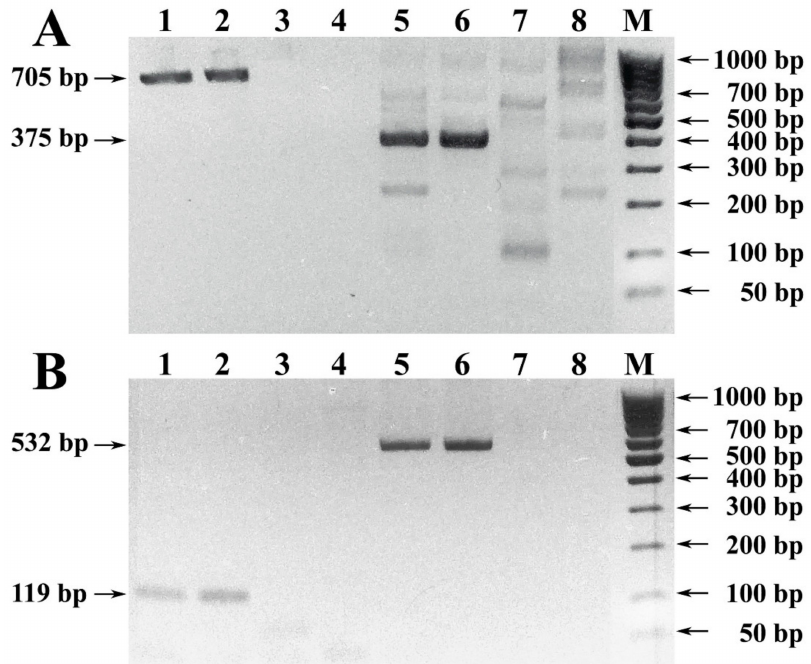
Figure 1. Electrophoregram of results of PCR amplification of the Vitis vinifera L. UFGT and F3H gene loci. Legend: ( A 1–4) Amplified with primers Vv1-Fwd and Vv1-Rev PCR samples of DNA extracted from grape pulp and precipitated wine debris: ( A 1) grape pulp of Chardonnay; ( A 2) grape pulp of Cabernet Sauvignon; ( A 3) precipitated wine debris of Chardonnay; ( A 4) precipitated wine debris of Cabernet Sauvignon. ( A 5–8) Amplified with primers F3H_H1fwd and F3H_H1rev PCR samples of DNA extracted from grape pulp and precipitated wine debris: ( A 5) grape pulp of Chardonnay; ( A 6) grape pulp of Cabernet Sauvignon; ( A 7) precipitated wine debris of Chardonnay; ( A 8) precipitated wine debris of Cabernet Sauvignon. ( B 1–4) Amplified with primers Vv3-Fwd and Vv3-Rev PCR samples of DNA extracted from grape pulp and precipitated wine debris: ( B 1) grape pulp of Chardonnay; ( B 2) grape pulp of Cabernet Sauvignon; ( B 3) precipitated wine debris of Chardonnay; ( B 4) precipitated wine debris of Cabernet Sauvignon. ( B 5–8) Amplified with primers F3H_H2fwd and F3H_H2rev PCR samples of DNA extracted from grape pulp and precipitated wine debris: ( B 5) grape pulp of Chardonnay; ( B 6) grape pulp of Cabernet Sauvignon; ( B 7) precipitated wine debris of Chardonnay; ( B 8) precipitated wine debris of Cabernet Sauvignon. (M) DNA size markers 100 bp + 50 bp (SibEnzyme).